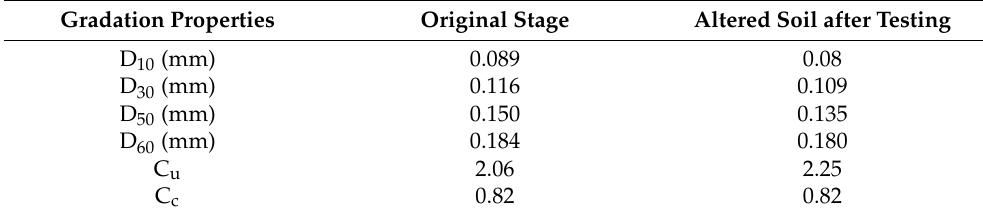
Figure 6. Histogram of the absolute variations for each particle size of the altered sand (after testing) in respect to the original material. Table 5. Variation of the sand gradation properties after testing.